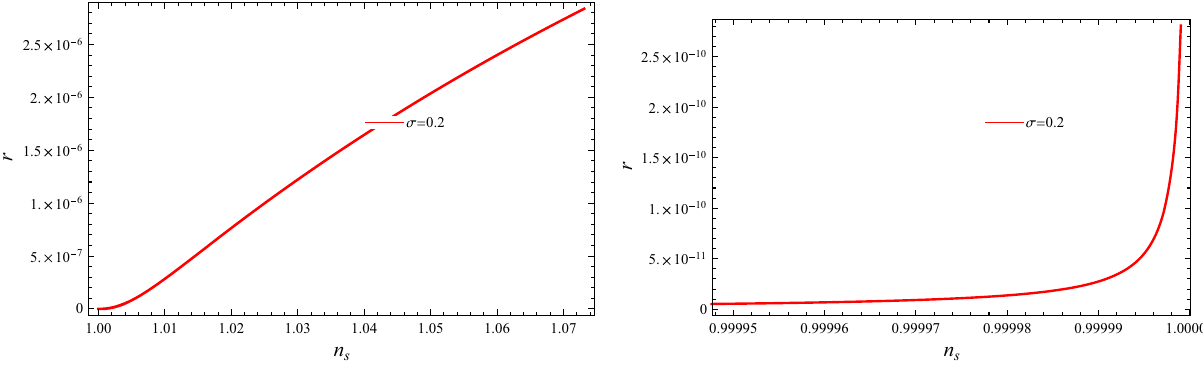
Fig. 17 Plot of r versus n s for GCCG model in weak (left panel) and strong (right panel) dissipative regimes for negative potential with n = − 1